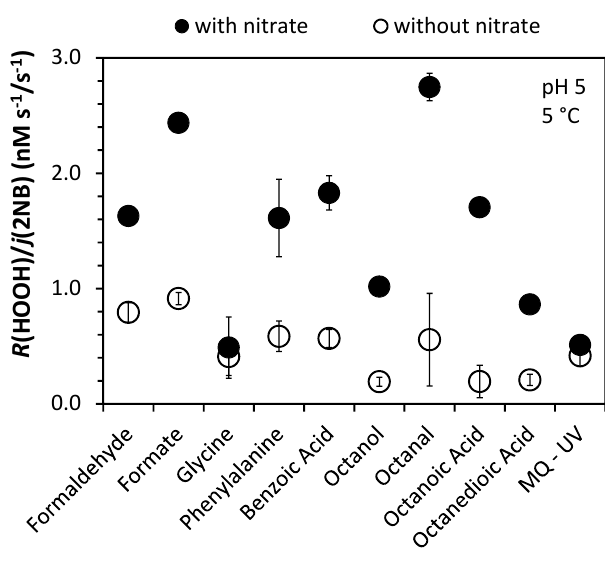
Fig. 2. Production of hydrogen peroxide normalized to measured j (2NB) in illuminated solutions (pH 5, 5 ◦ C) containing 200µM model organic compound and either no nitrate (open circles) or 500µM nitrate (closed circles). UV Milli-Q water did not contain a model compound. Error bars ( ± 1SE) are the absolute error (net in- determinate error), calculated based on the propagated errors from R (HOOH) and j (2NB). Some points are average values from sev- eral experiments with the same compound.